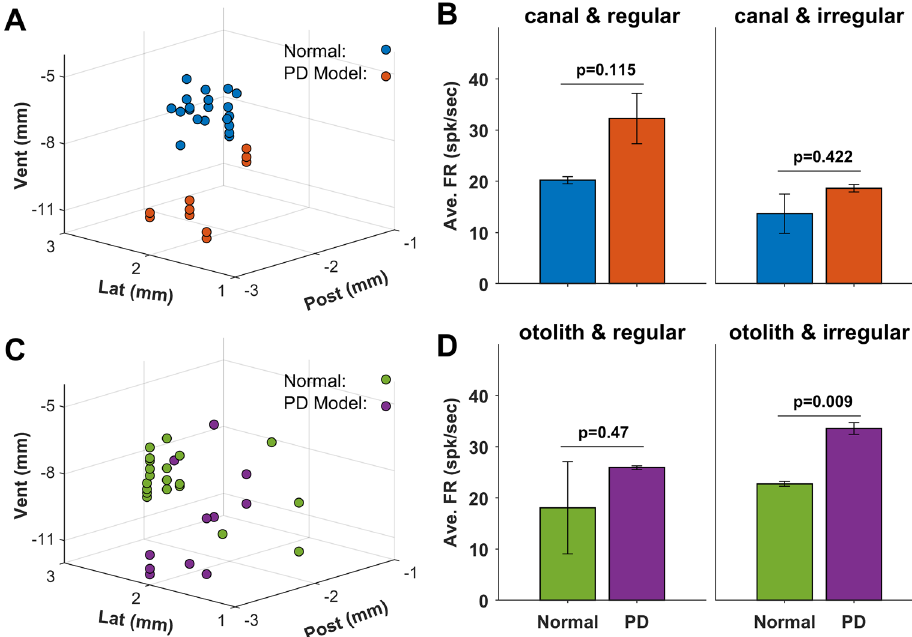
Figure 3. Extracellular neural recording position ( A & C ) and the population of the averaged firing rates (FR) for canal ( B ) and otolith ( D ) from normal (blue & green) and PD (orange & purple). Each group is subdivided into the regular and the irregular units based on the discharge regularity. Except the otolith and irregular group, all average FRs increased after the construction of PD with no statistical significance ( p > 0.115).